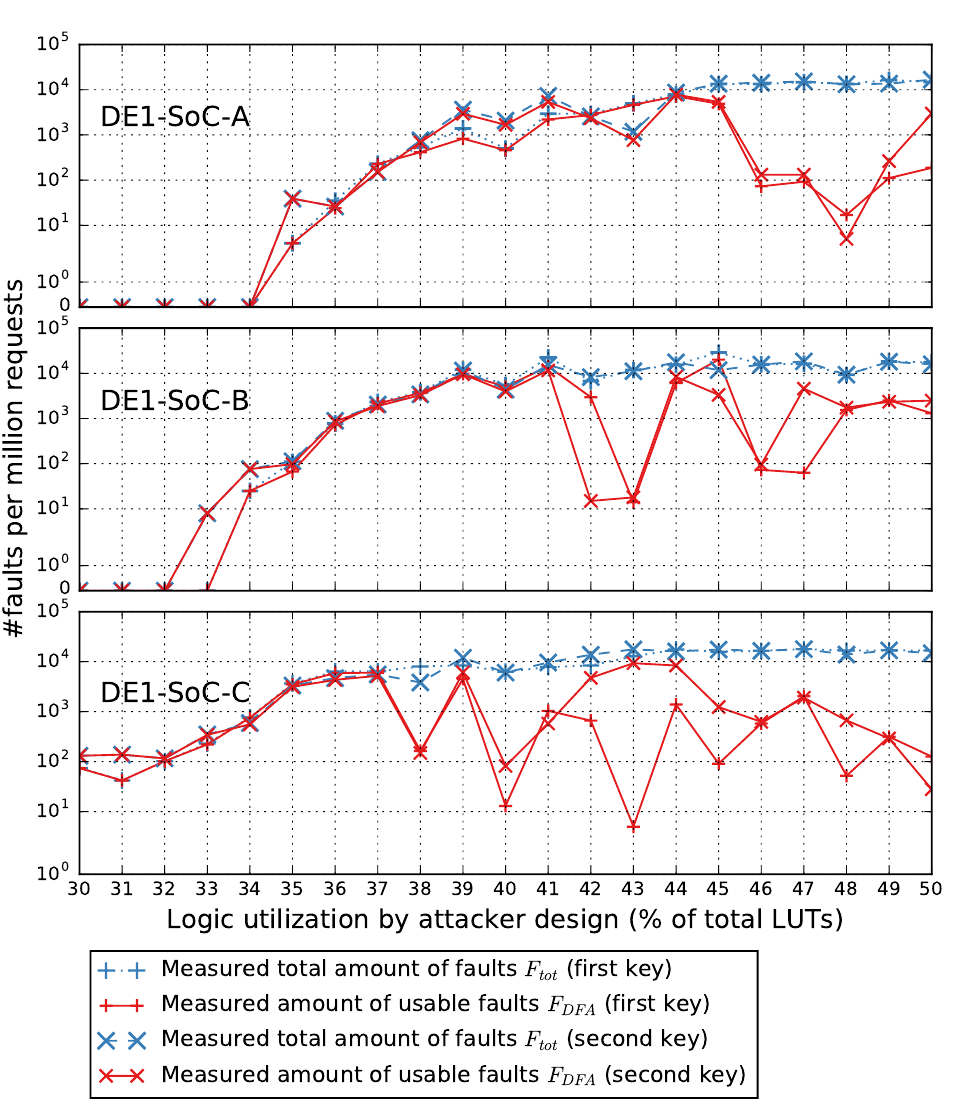
Figure 11: Total measured fault injection rates F tot and measured injection rate of faults usable in DFA F DFA with respect to the amount of logic utilization (percentage of total LUTs) by the attacker design for three different Terasic DE1-SoC boards and two different random encryption